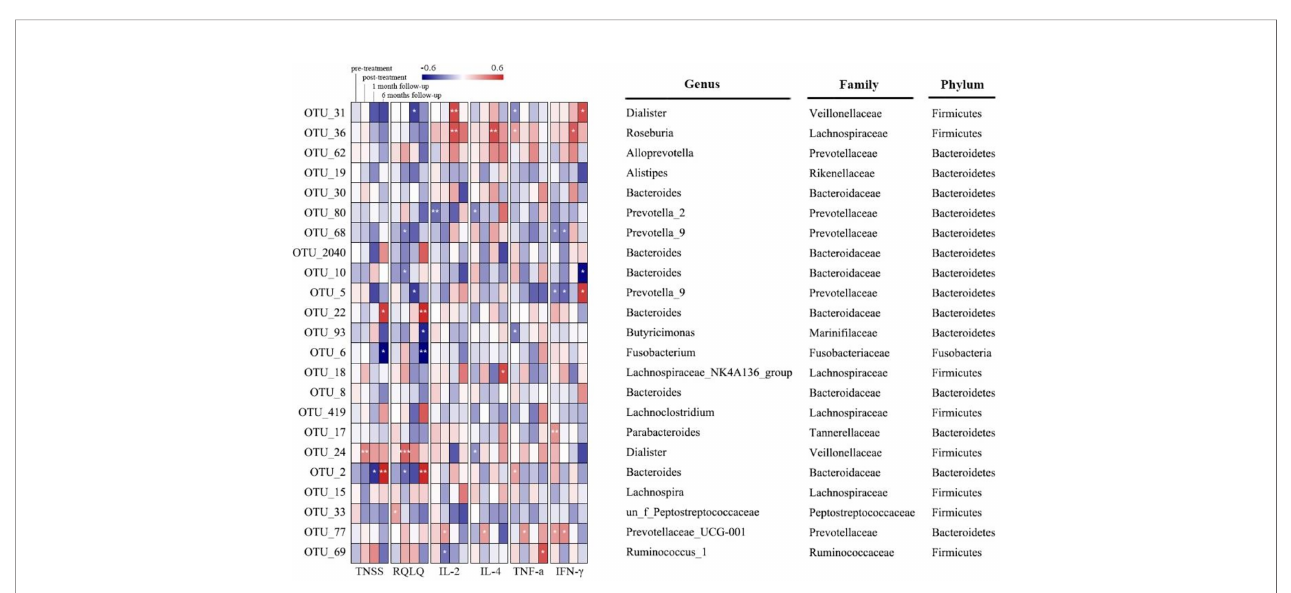
FIGURE 5 | Correlation between distinguished bacterial taxa and TNSS, RQLQ, or cytokines based on Spearman ’ s correlation test (* means p <0.05; ** means p <0.01; *** means p <0.001.).